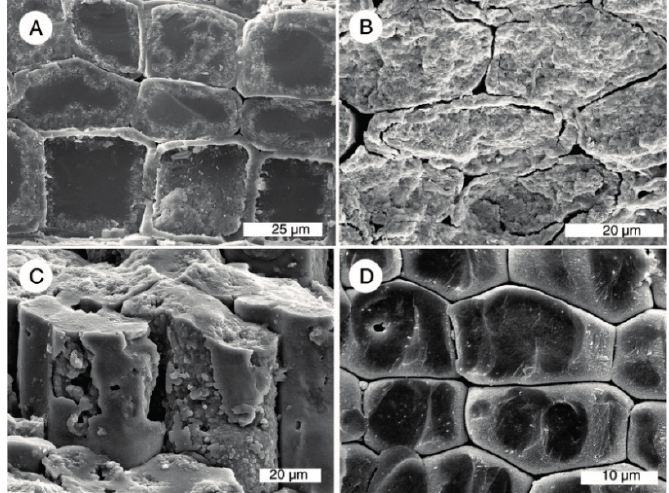
Figure 13. Open intercellular spaces in opal-CT wood. ( A ) Transverse view, locality 2 (Bonanza opal mine); ( B ) Transverse view, locality 2 (Norita opal mine); ( C ) Oblique radial view, locality 16; ( D ) Transverse view, locality 2 (Rainbow Ridge opal